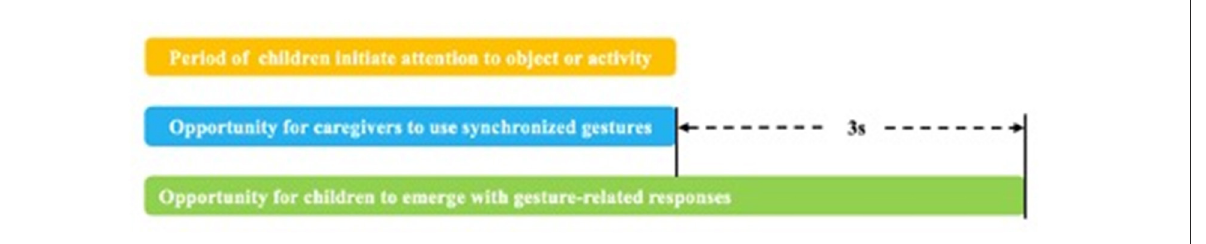
FIGURE2 Synchronized gestures of the caregiver and gesture-related responses of the child. (1) After the child initiates attention to an object or activity in a dyadic activity (yellow bars), synchronized gestures in which the caregiver synchronizes with the toddlers’ attention may occur during this period (blue bars). (2) The toddlers’ gesture-related response to the caregiver’s gesture was confirmed during the period from the time the gesture was presented until 3s after the end of the gesture.